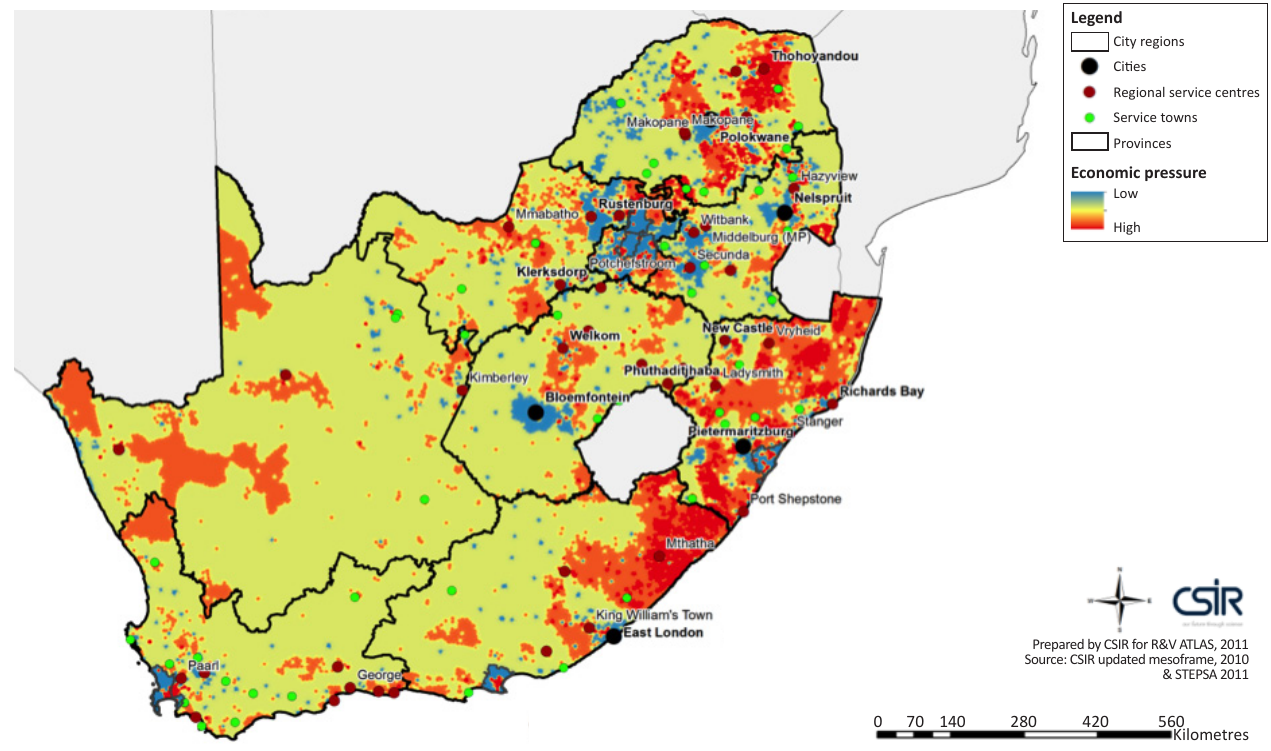
FIGURE 2: South Africa’s economic pressure